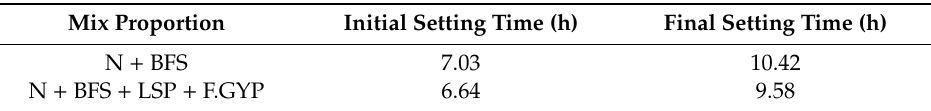
Table 5. Setting time of concrete.